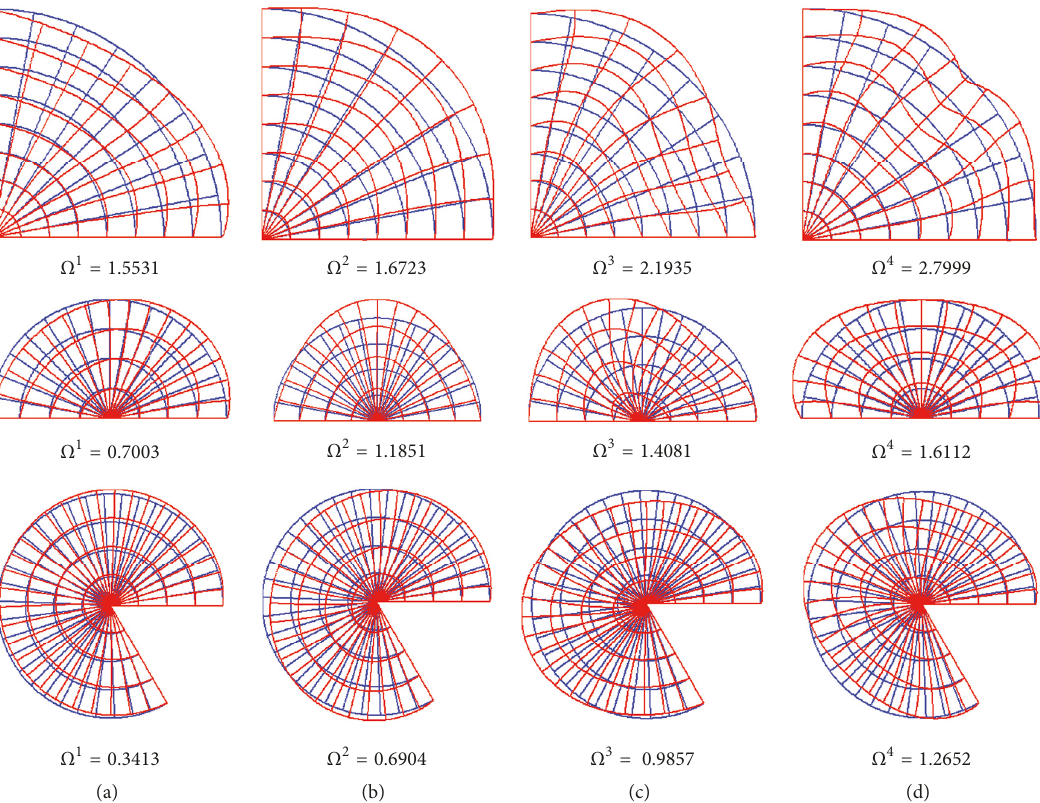
Figure 9: The first seven mode shapes of CFC circular sector plate with different sector angles, that is, 𝜙 = 90 ∘ , 180 ∘ , and 300 ∘ .